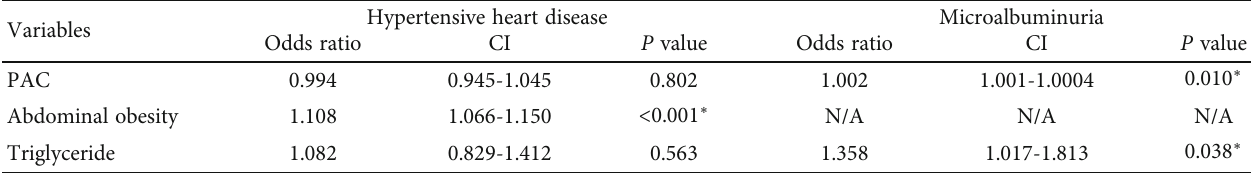
Table 3: Multinomial logistic regression analysis for the variable with organ damage. Variables